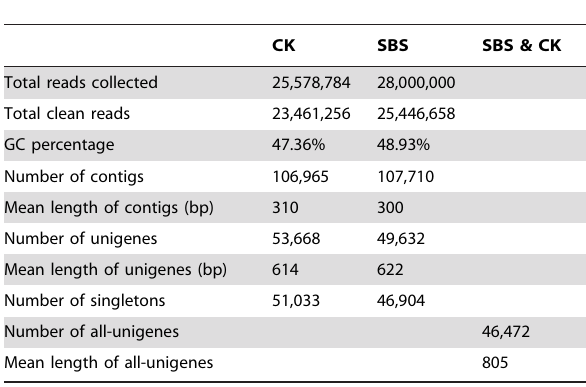
Table 1. Summary of the transcriptome reads for the normal control (CK) fruit and fruit with surface brown spots disease (SBS).